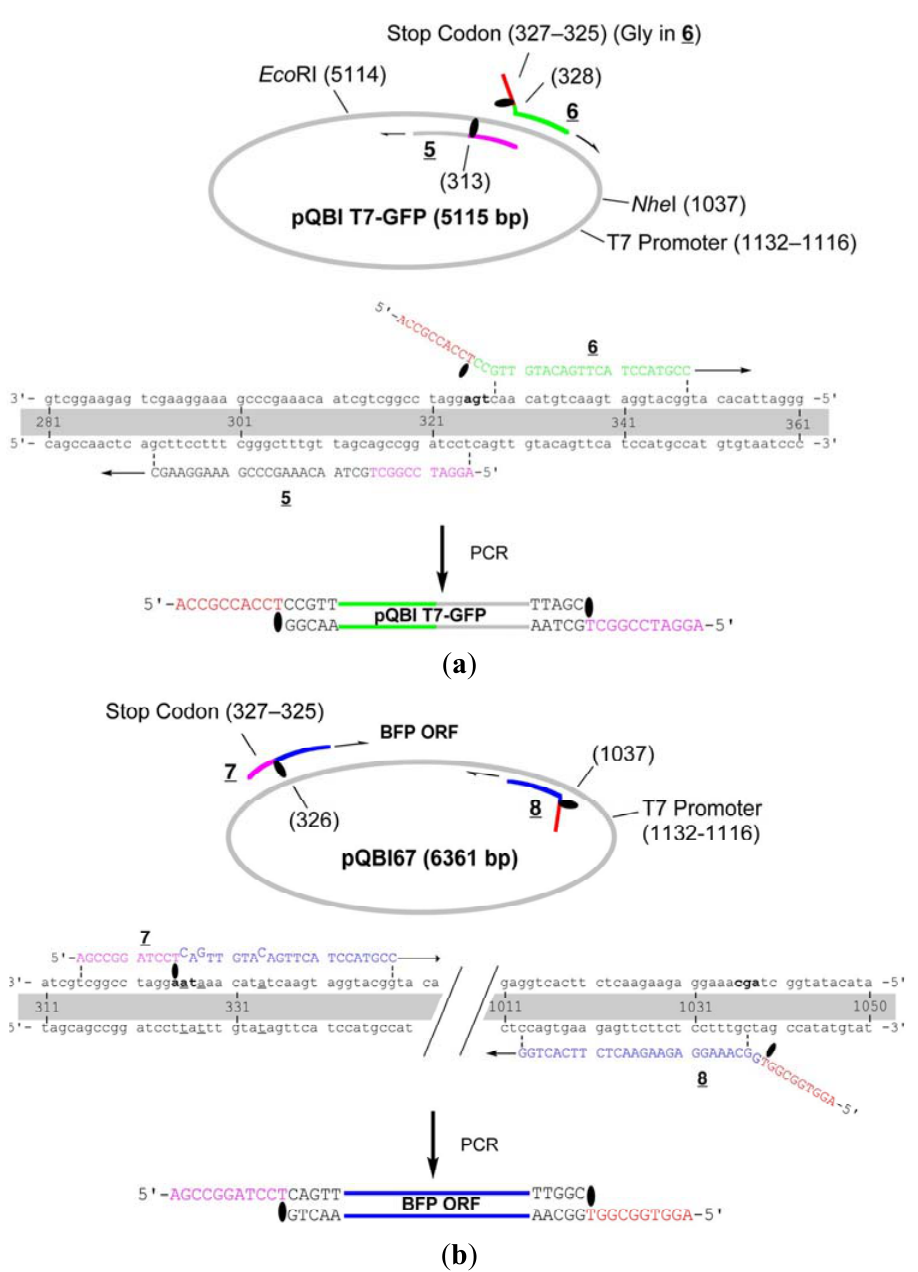
Figure 3. Detailed structure of the primers for the construction of the fusion recombinant. ( a ) Primers for the vector fragment; ( b ) Primers for the insert. The opal stop codon in